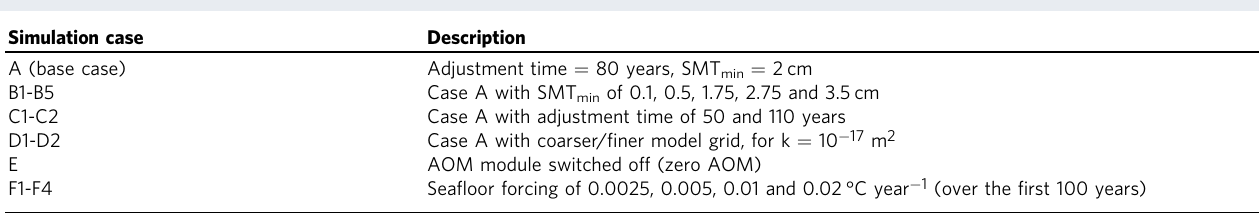
Table 1 Model simulations included in the present study *